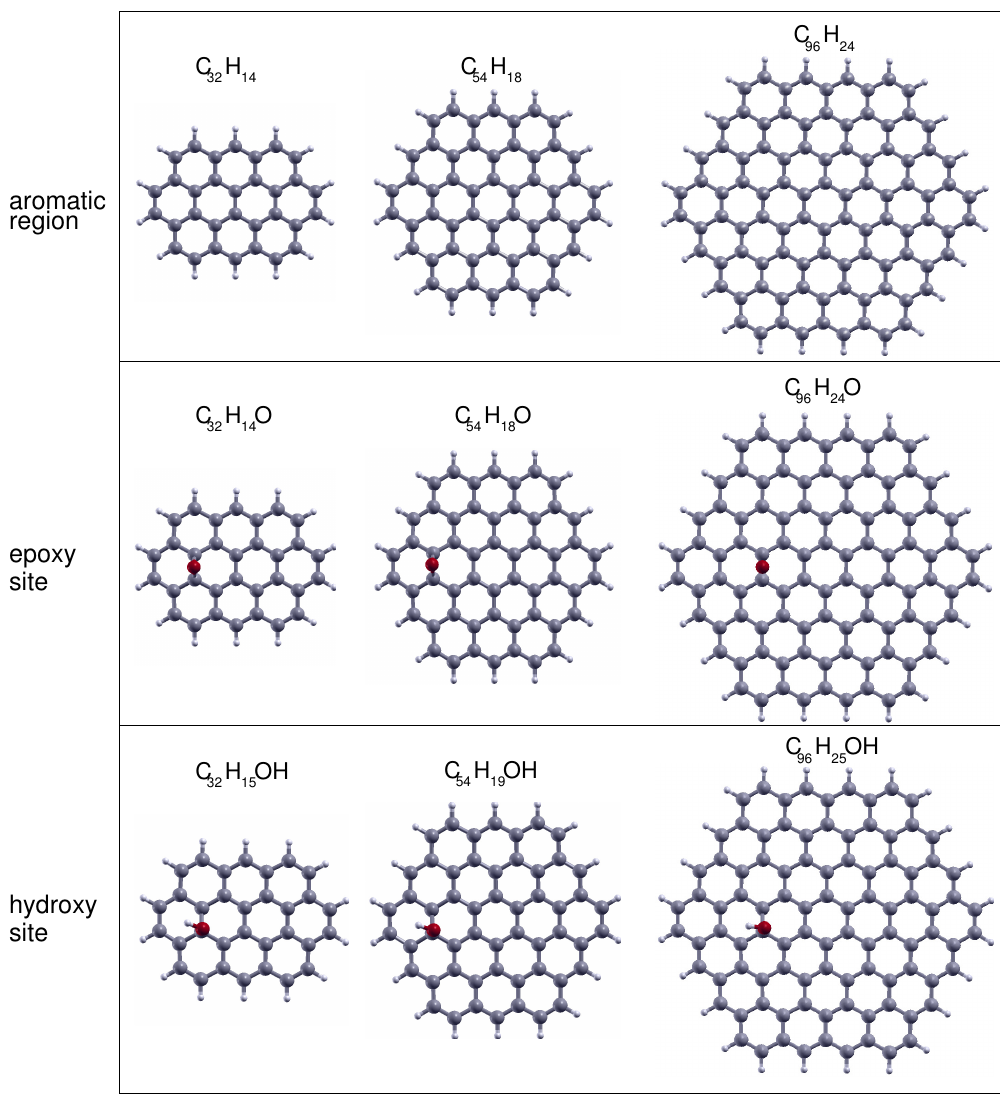
Figure 1. Graphene oxide molecular prototypes of increasing size. Those describing the aromatic region (first row) are ovalene (C 32 H 14 ), circumcoronene (C 54 H 18 ) and circumcircumcoronene (C 96 H 24 ). The prototypes describing the oxidized sites are obtained by adding one epoxy (second row) or one hydroxy (third row) group to those of the first